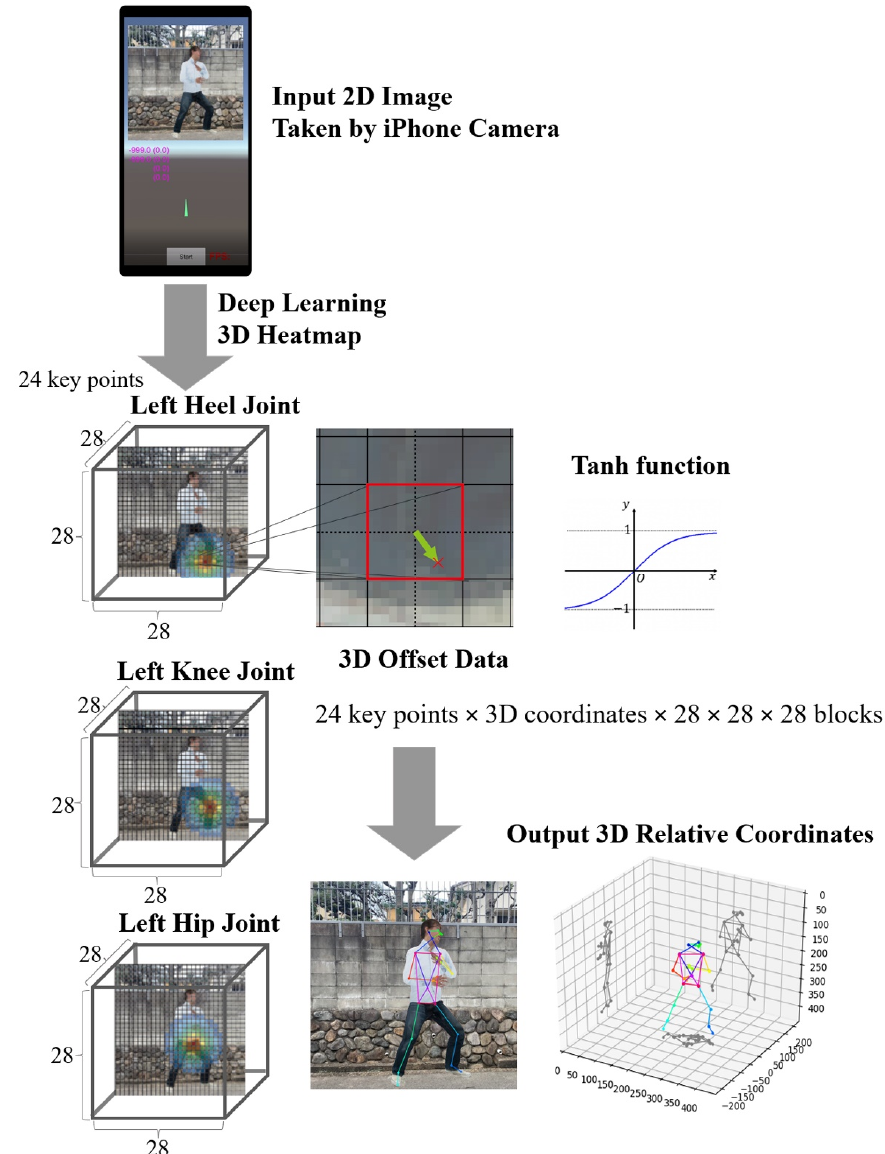
Figure 3. Output 3D relative coordinates of 24 key points on 3D heatmaps.